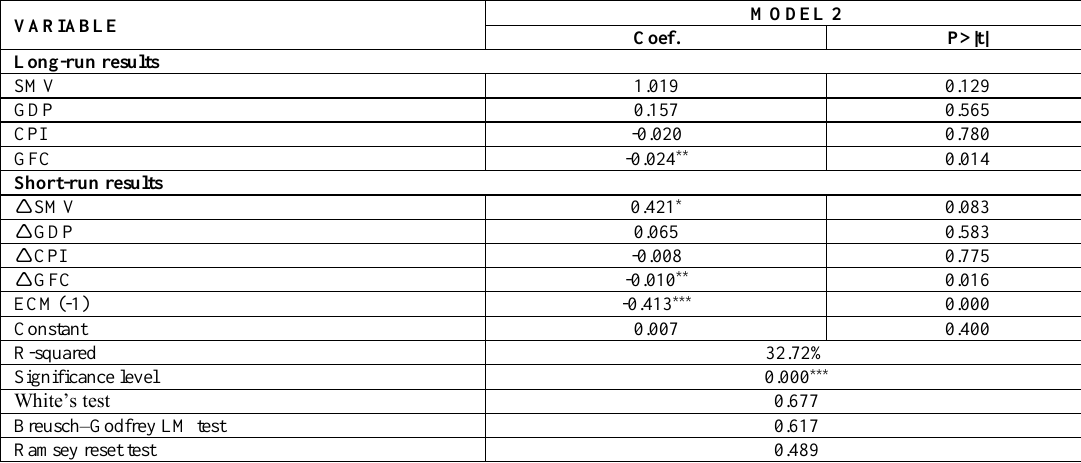
Table 5. Coefficient estimation results (Model